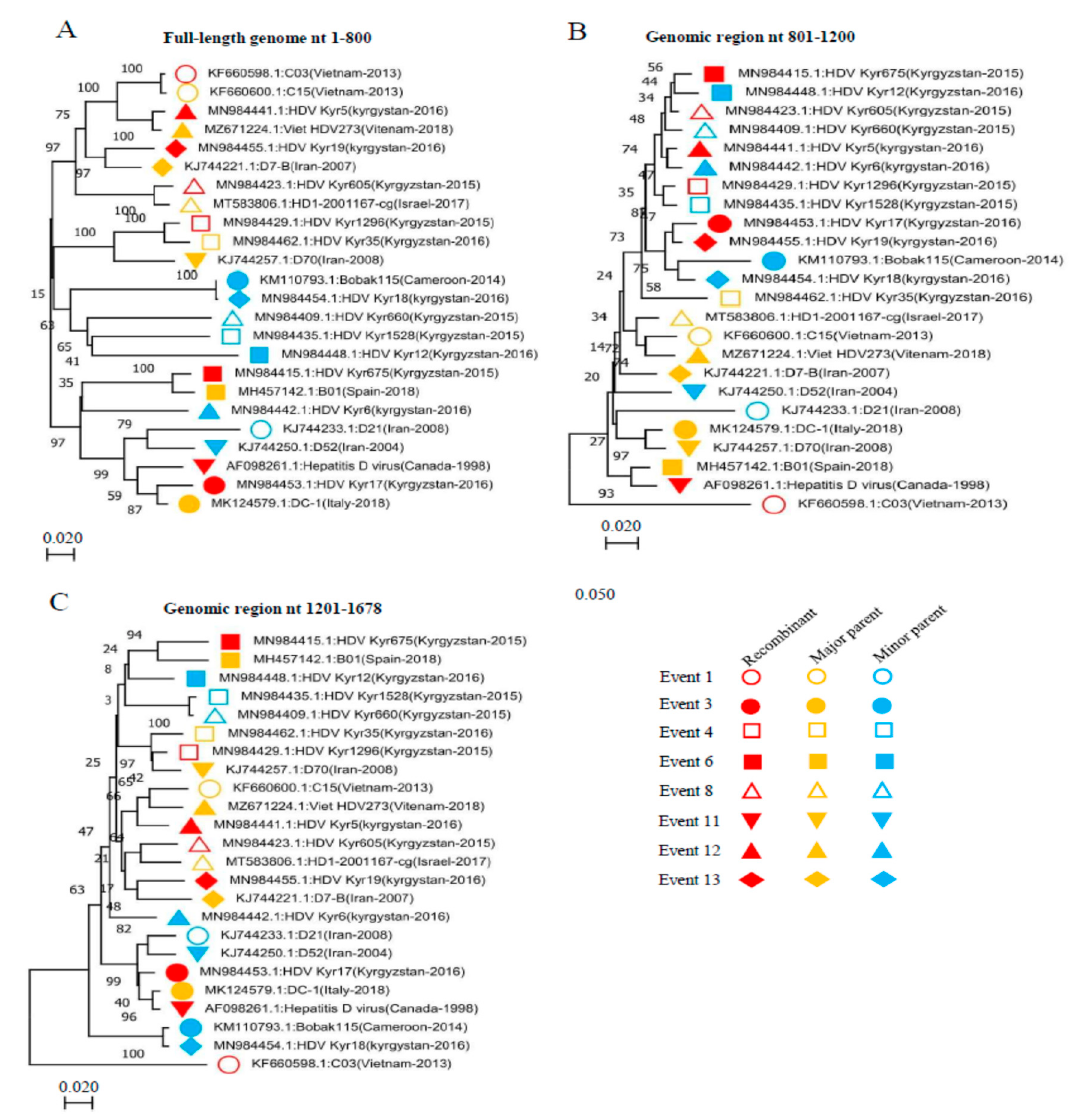
Figure 5. Phylogenetic trees based on three different HDV-RNA genomic regions. ( A ) nt 1–800. ( B ) nt 801–1200. ( C ) nt 1021–1678. Twenty-four HDV strains involved in the recombination events (Event 1, 3, 4, 6, 8, 11, 12, and 13), as an example, were analysed using phylogenetic trees to further confirm the recombination events. The recombinants, minor and major parents, are indicated in red, blue, and yellow colours,